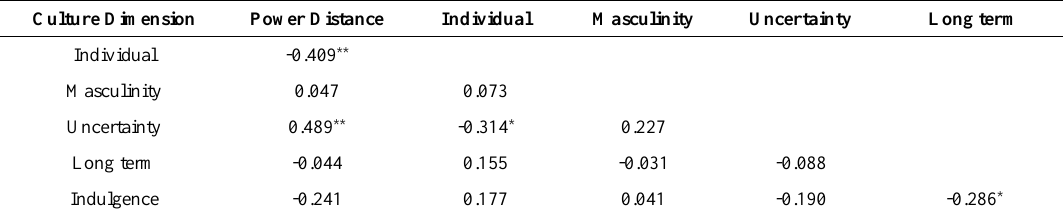
Table 1. Relationship between independent variables (six cultural dimensions)